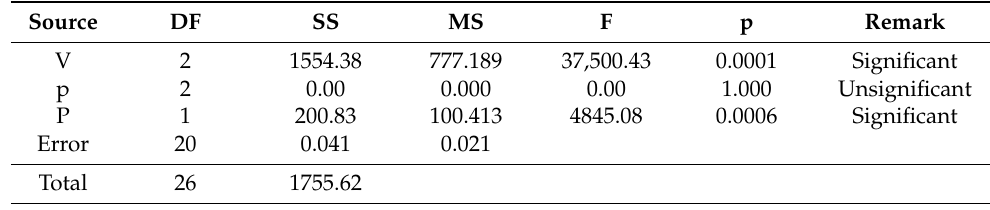
Table 12. ANOVA results for linear energy.